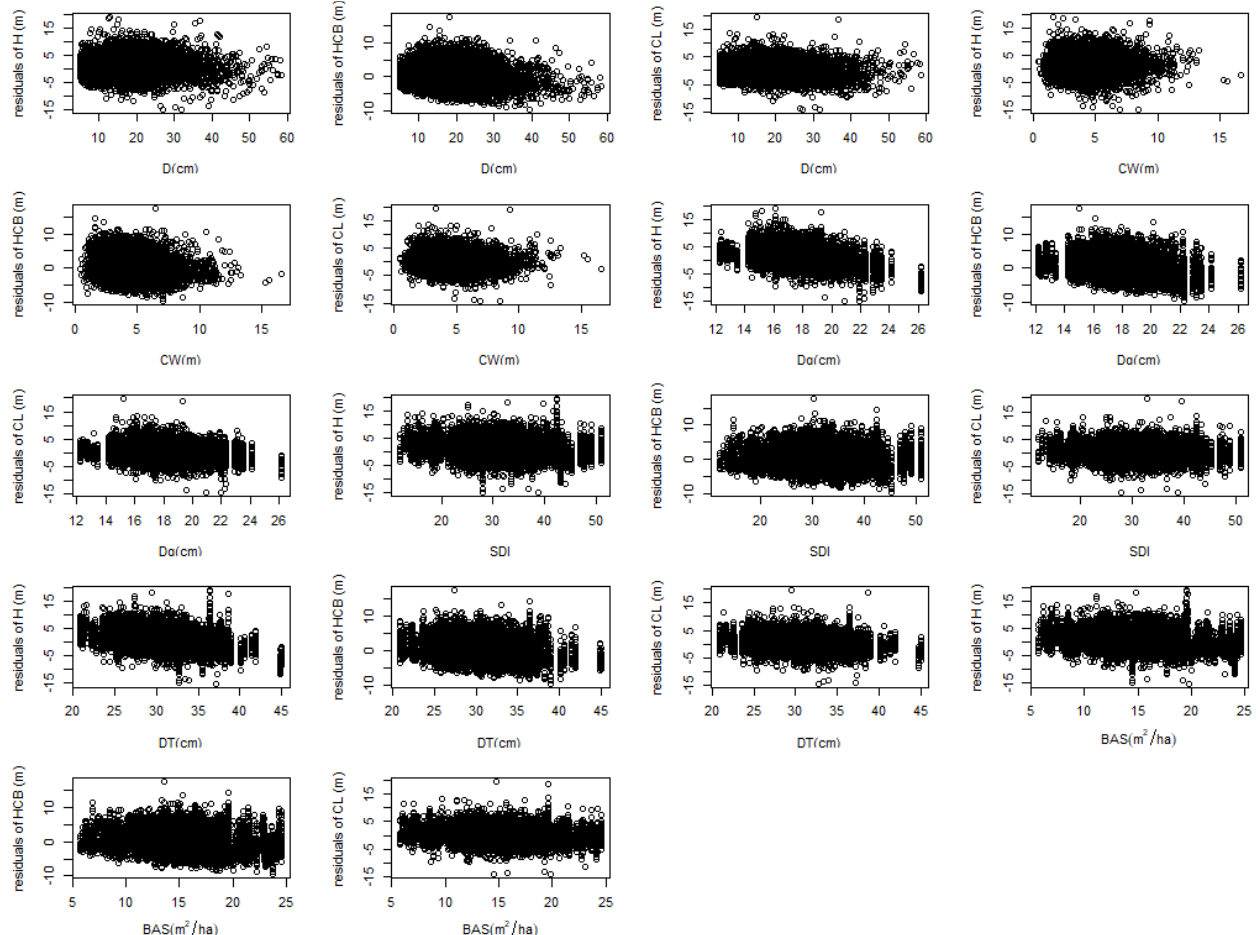
Figure 4. Residuals against predictors of Equation (19) ( D : diameter at breast height (cm); CW : crown